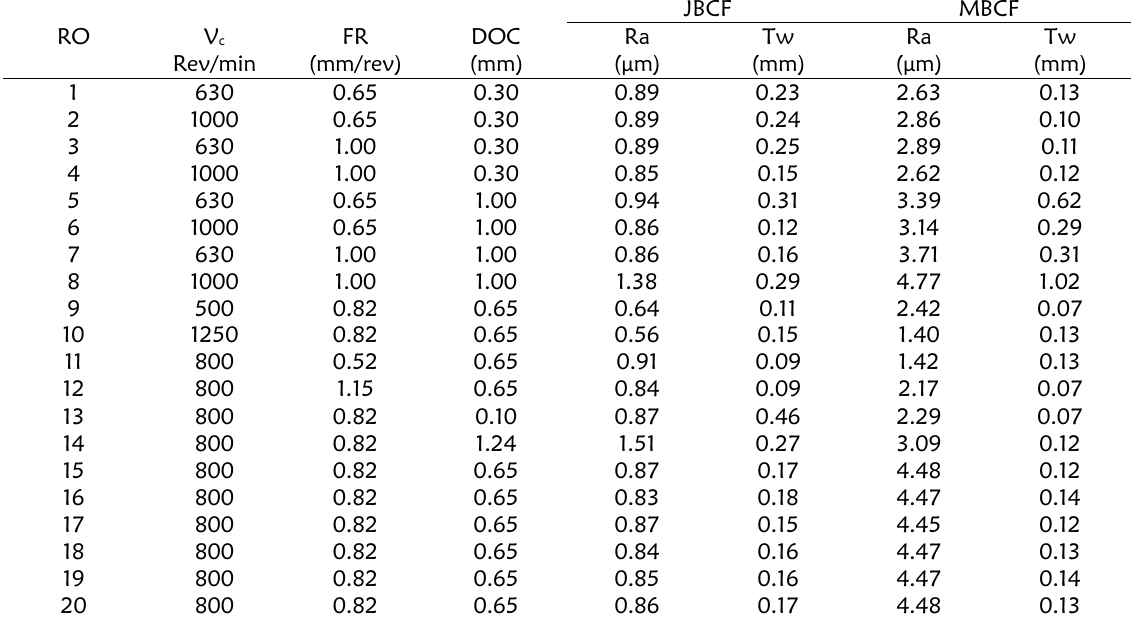
Table 10: Experimental result for different cutting fluids